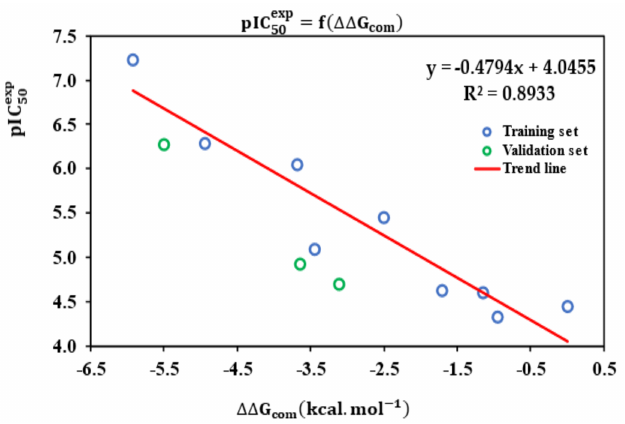
Figure 2. Correlation plot between pIC exp the training set of nine FP3